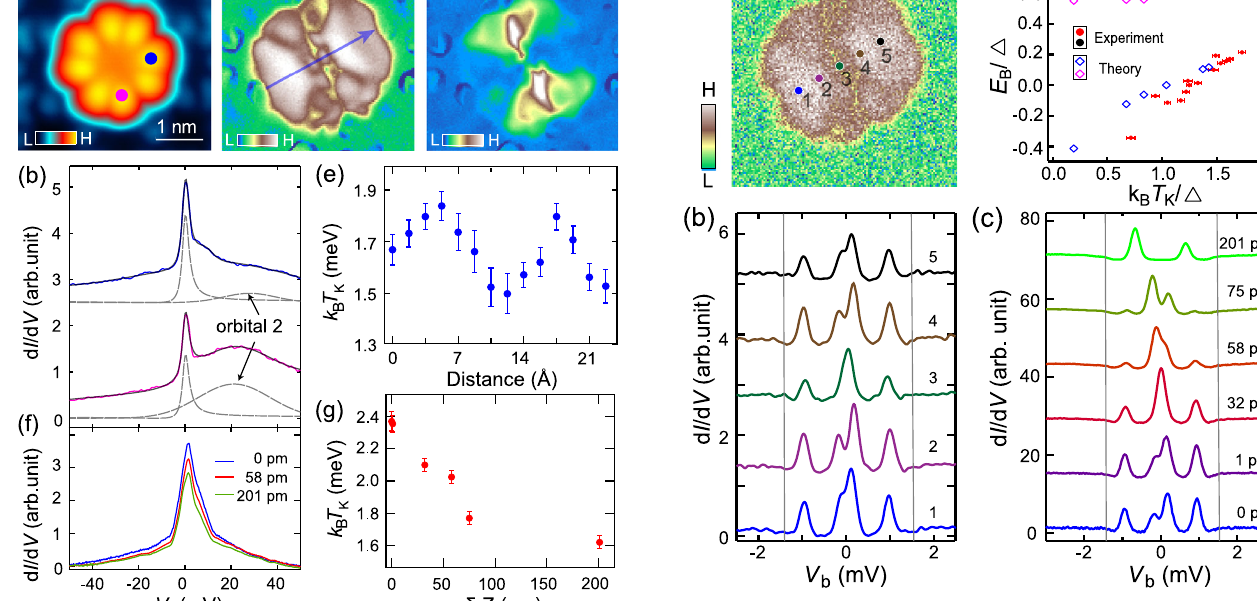
Fig. 3 | YSR state of Tb 2 Pc 3 . a d I /d V mapping of the Tb 2 Pc 3 in Fig. 2a at 0.3mV, showing the intensity distribution of the YSR state. ) Selective spectra ( V =10mV and I =100 pA) taken at the indicated positions in ( a ). The gray lines depict the energies of the superconducting coherence peaks of Pb. c Variation of YSR states takenatthesamelocationofaTb 2 Pc 3 withdecreasingtipheight δ Z .The δ Z =0pm value is set at V =10mV and I =50 pA. d Statistics showing the relation between E b and T K relative to the Pb superconducting gap Δ . Black (red) solid dots are experimental outer (inner) YSR state. Pink (blue) hollow dots are theoretically calculated outer (inner) YSR